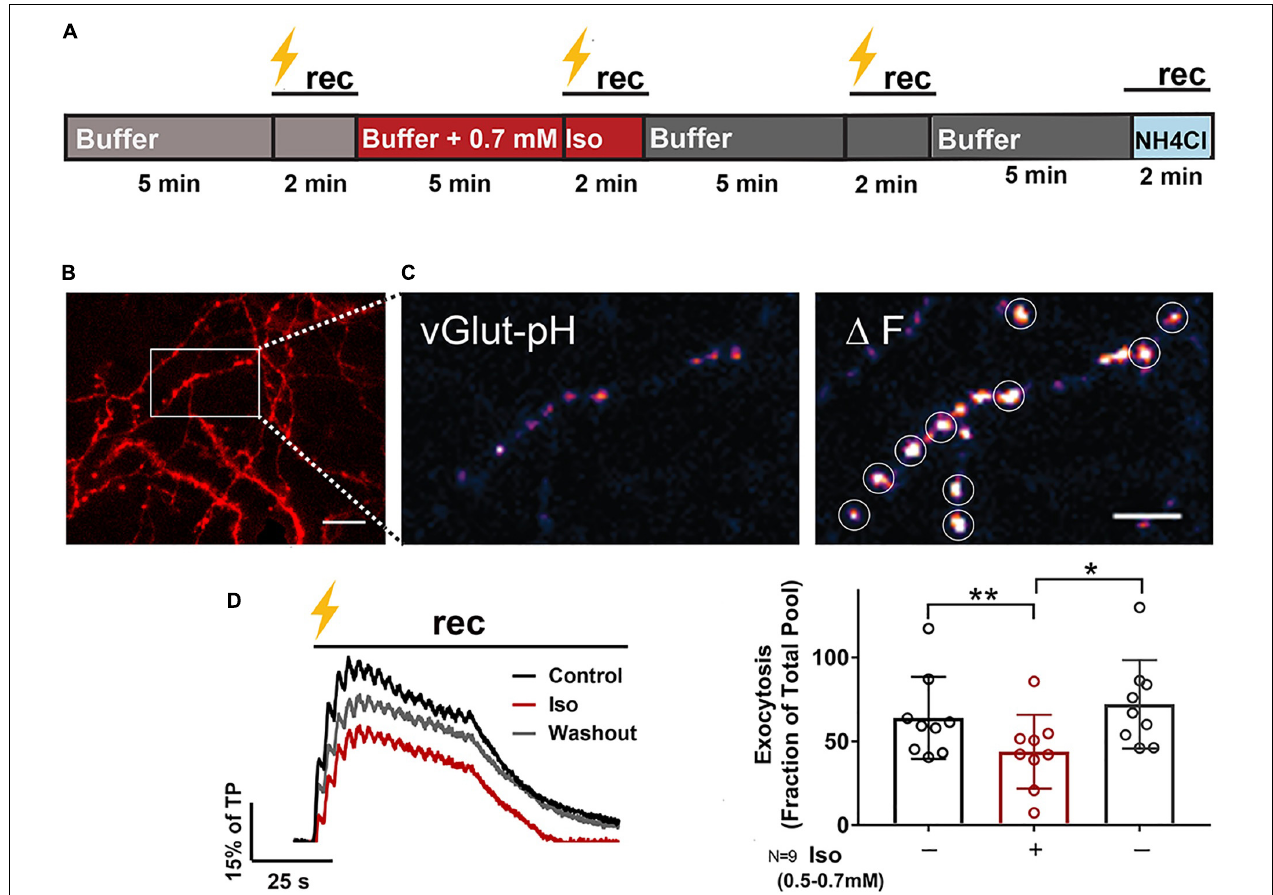
FIGURE 1 | Isoflurane reversibly inhibits electrically-evoked synaptic vesicle exocytosis. Rat hippocampal neuron cultures (16DIV) transfected with vGlut-pH and mCherry were perfused with 0.5–0.7 mM isoflurane or control buffer with tetanic stimulation (lightning bolt) and imaged as indicated in (A) . Cells were equilibrated with control buffer or buffer with isoflurane for 5 min prior to stimulation and time-lapse recording for 2 min. Representative images showing dendritic arbor and axons of a control neuron ( B , mCherry). Inset shows single boutons (vGlut-pH) before ( C , left) and after ( C , right) tetanic stimulation with defined ROIs used for analysis (white circles). Representative paired traces of electrically-evoked synaptic vesicle exocytosis (black bar, tetanic stimulation) of ROIs (average of ∼ 50) from a single neuron under control, isoflurane, and washout conditions during 2 min recording ( D , left). Peak synaptic vesicle exocytosis was reduced by isoflurane (D , right; peak fluorescence) (** p < 0.01 by one-way multiple comparisons ANOVA with Dunnett’s post-hoc test) and recovered following washout ( D , right; peak fluorescence) (* p < 0.05 by one-way multiple comparisons ANOVA with Dunnett’s post-hoc test). Data are mean ± SD%; n = 9 neurons per experimental group and 405–450 boutons. Scale bar = 5 µ